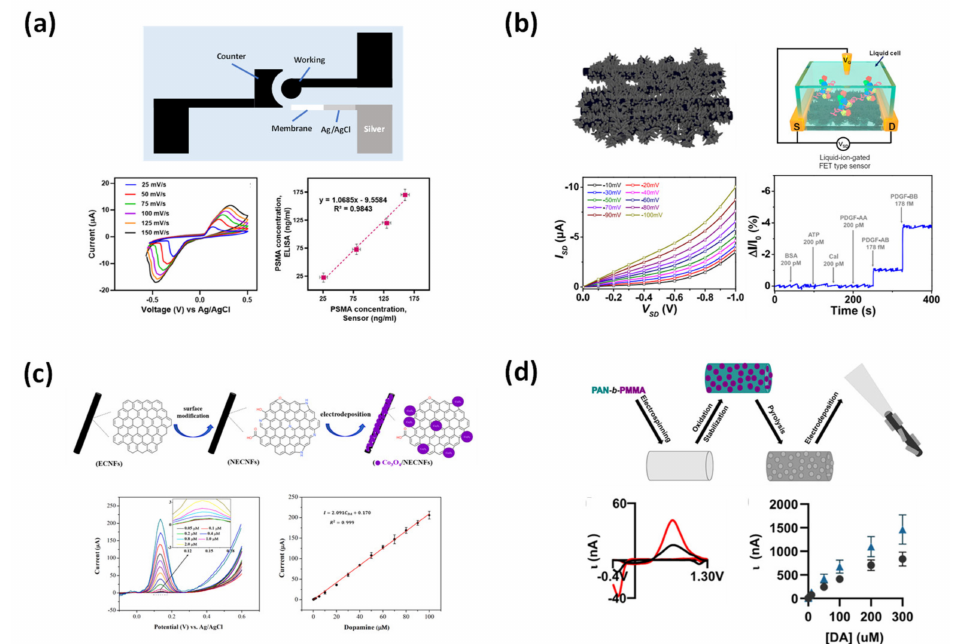
Figure 20. ( a ) CNFs treated with nitric acid as working electrode material for PSMA sensors [143]. ( b ) 3D nanoweb CNFs as channel material for PDGF − BB detecting transistors [144]. ( c ) CNFs decorated with Co 3 O 4 for detection of DA [145]. ( d ) CNFs deposited on carbon electrodes for DA detection